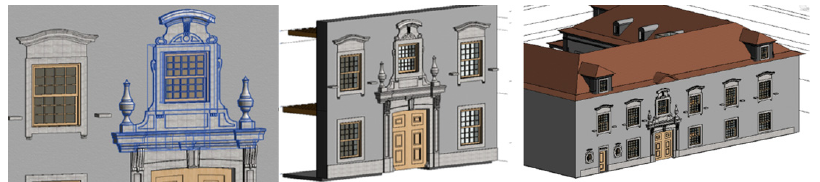
Figure 22. Complete windows and the principal door in the main façade.